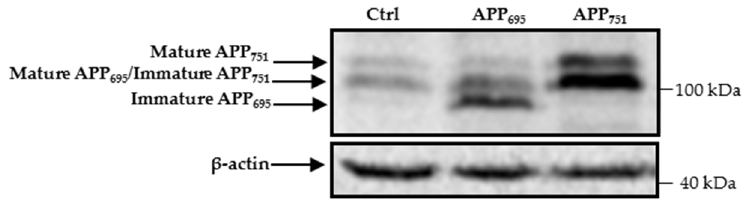
Figure 1. HEK293 cells express different APP isoforms. Western blotting of APP and actin in cell lysates of HEK293 transfected with control, APP 695, or APP 751 cDNAs. The different APP isoforms are indicated by arrows on the left side of the membrane. Immature and mature forms of APP 770 were not analyzed in this work and therefore location of these isoforms is not indicated. Molecular mass markers are shown on the right.